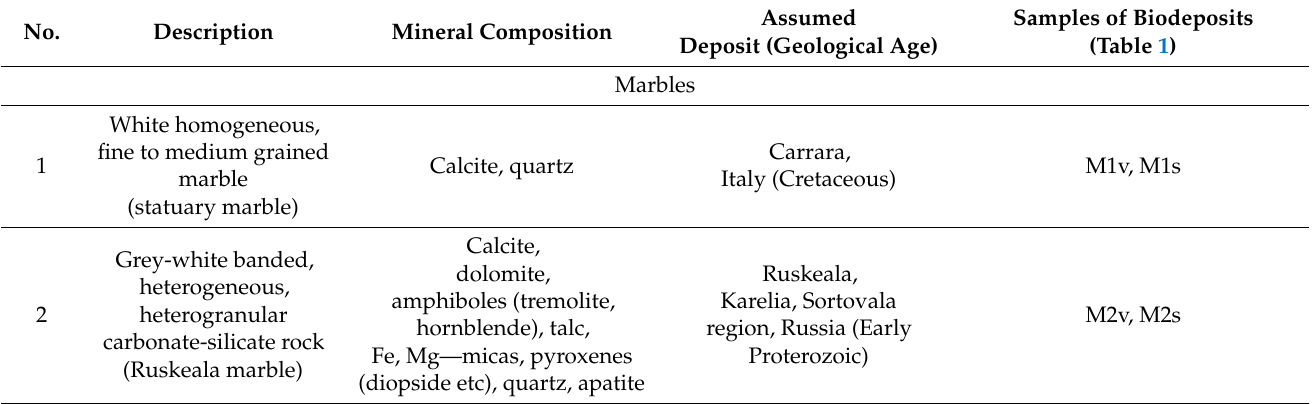
Table 2. Mineral and petrographic characteristics of underlying rocks